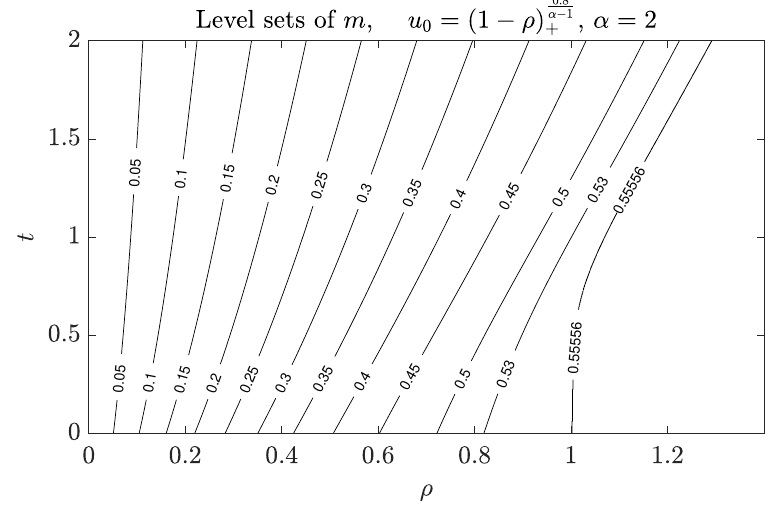
Fig. 10: Level sets of the numerical solution not given by characteristics presented in Remark 3.8, which does not have waiting time due to Theorem